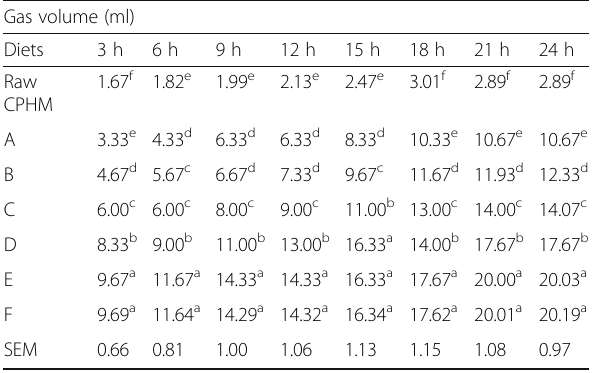
Table 3 In vitro gas production of raw and replacement